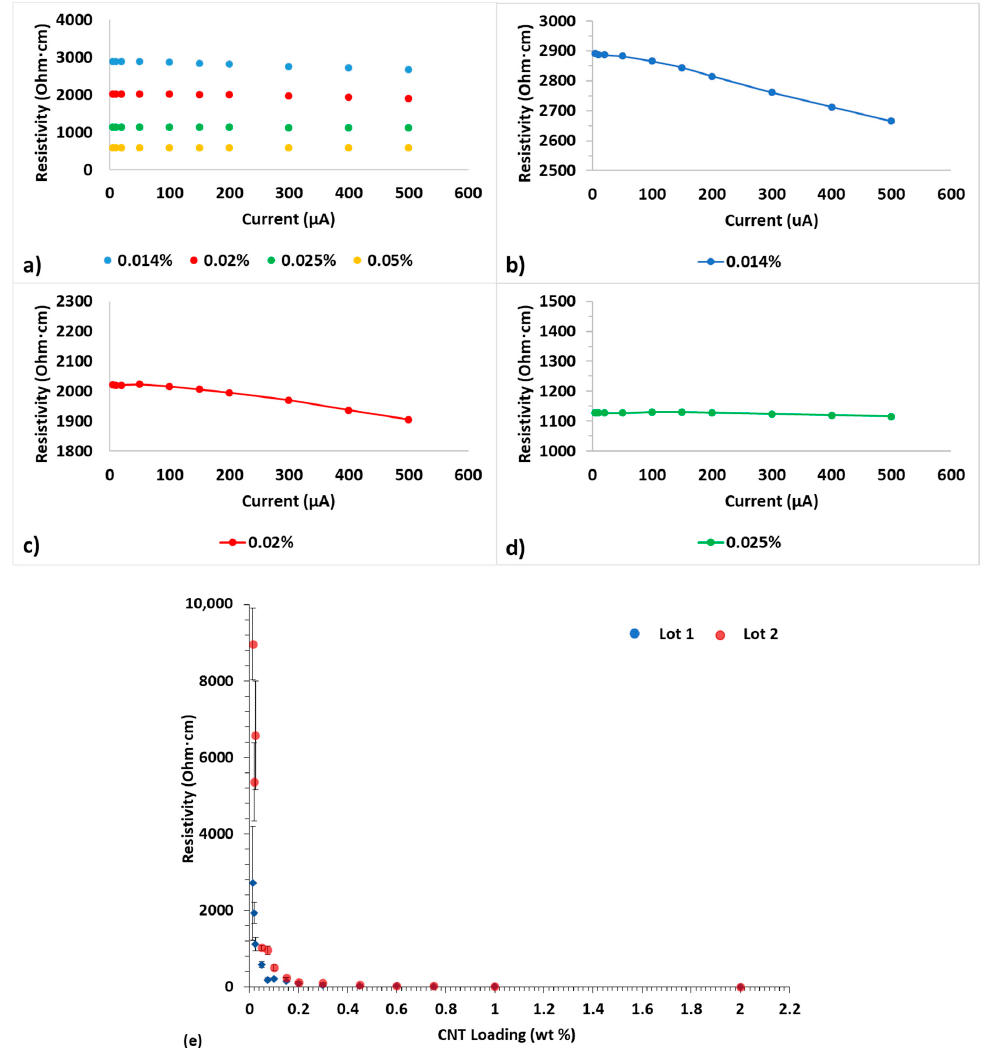
Figure 1. DC current effect on resistivity from 5 to 500 μ A—( a ) comparison for various CNT loadings, ( b ) 0.014 wt% CNT loading, ( c ) 0.020 wt% CNT loading, ( d ) 0.025 wt% CNT loading. Graph ( e )